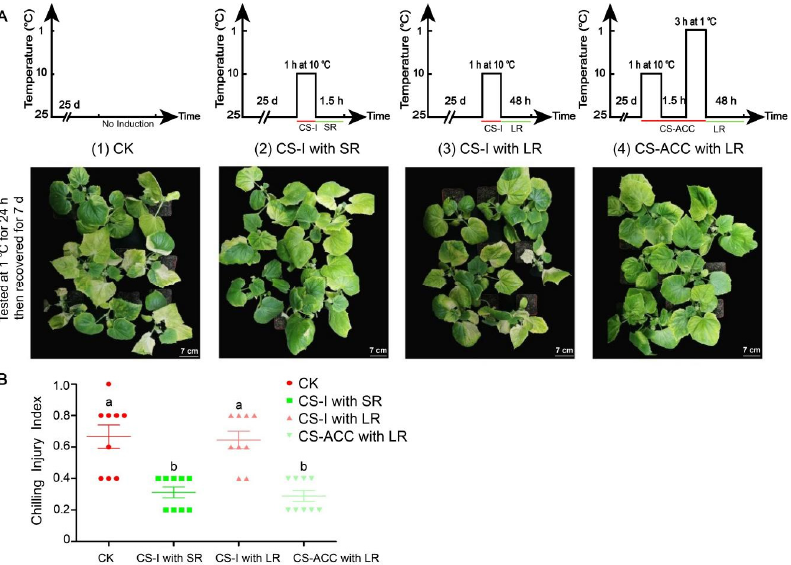
Figure 1. The cold tolerance ( A ) and chilling injury index (CII) ( B ) of cucumber seedlings tested by a tester cold stress (1 °C, 24 h) after different treatments, and then placed in recovery for a period (25 °C/18 °C, day/night, 7 days). ( A ): a schematic diagram and cold tolerance of different treatments of cucumber seedlings. CK: cucumber seedlings with no acclimation and at 25 °C during treatment; CS-I with SR: cucumber seedlings were treated with a cold stress regime of 10 °C for 1 h and 25 °C for 1.5 h; CS-I with LR: cucumber seedlings were treated with a cold stress regime of 10 °C for 1 h and 25 °C for 48 h; CS-ACC with LR: cucumber seedlings were treated with a cold stress regime of 10 °C for 1 h, 25 °C for 1.5 h, 1 °C for 3 h, and 25 °C for 48 h; CS-I: cold stress induction; CS-ACC: cold stress acclimation; SR: short recovery; LR: long recovery. ( B ): the chilling injury index (CII) of cucumber seedlings. The different letters indicate significant differences as assessed by the Turkey